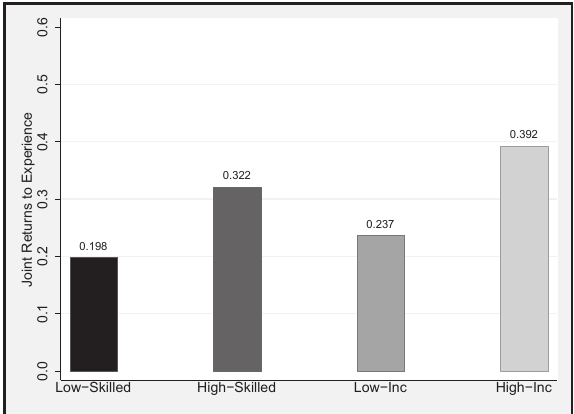
Figure 8 Average returns to experience – worker heterogeneity (two-digit